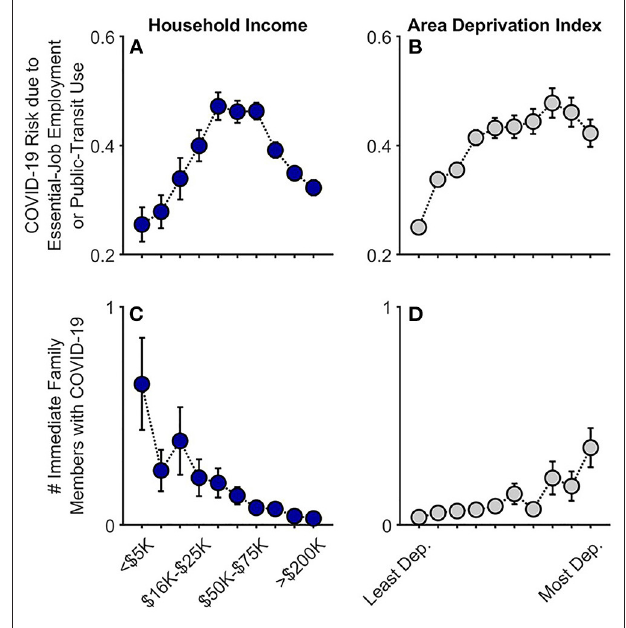
FIGURE 1 | COVID-19 exposure and within-family diagnoses as functions of annual household income and their home census tract’s area deprivation index. Caregiver-reported data are shown for whether individuals in participants’ households were at an increased risk given job type or public-transit use (A,B) and the number of participants’ immediate family members who had been diagnosed with COVID-19 (C,D) . Error bars are ± 1 between-subjects standard error of the means. Analyses controlled for caregiver education, caregiver race, caregiver ethnicity, and participants’ baseline study site. Given multiple observations, the job/transit risk analysis also controlled for questionnaire number and participant. Area deprivation index was collapsed across continuous deciles for graphing. Dep.,